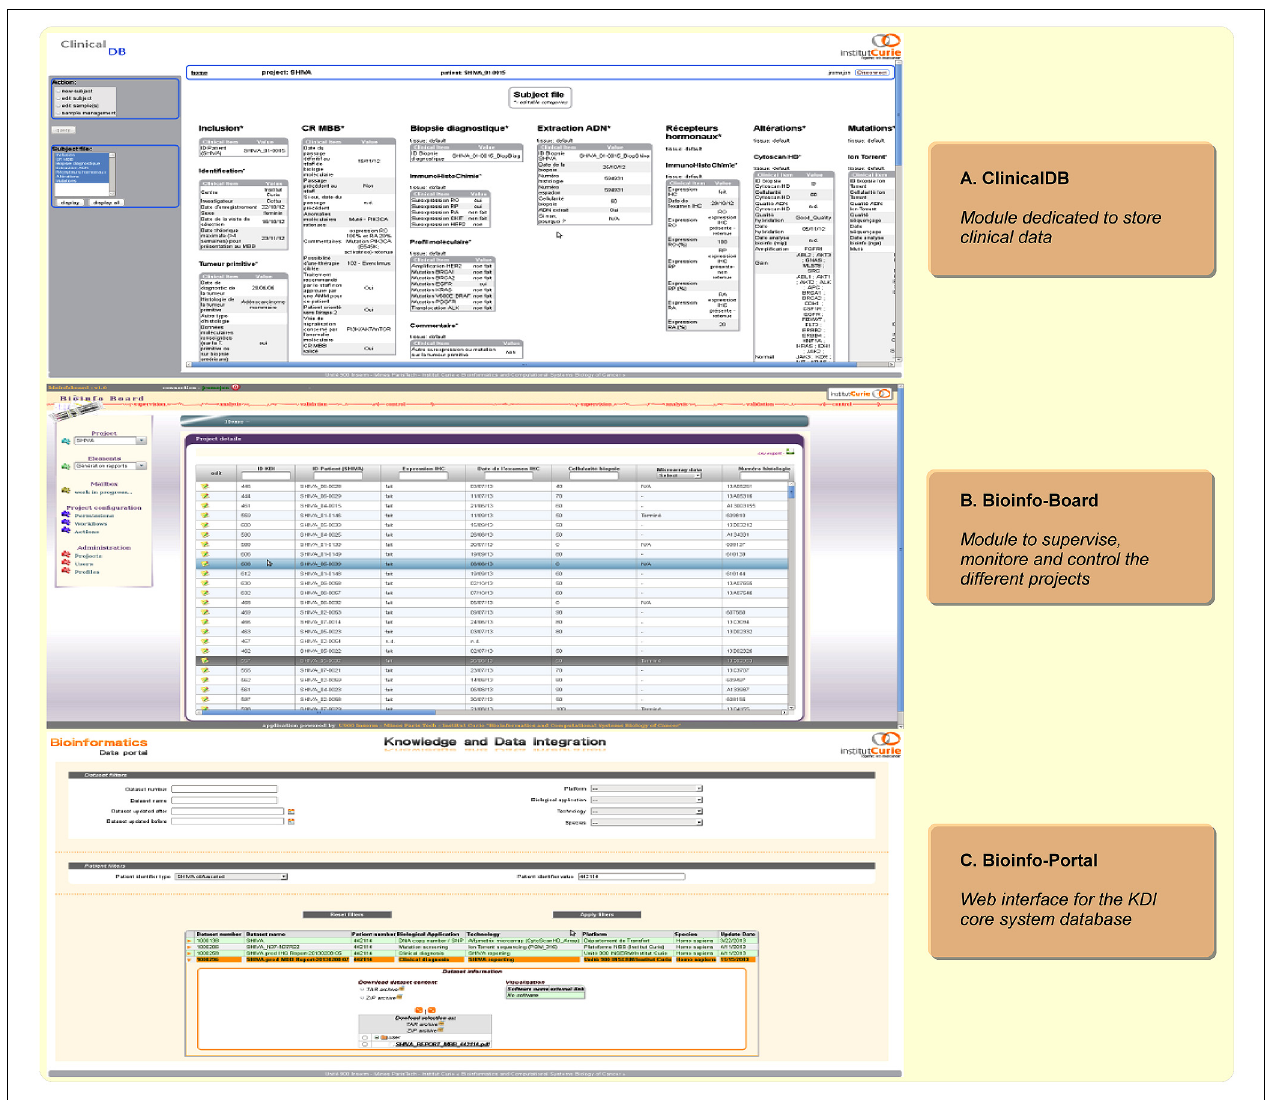
FIGURE 6 | Bioinformatics web applications screenshots. (A) Clinical DB application is dedicated to clinical data